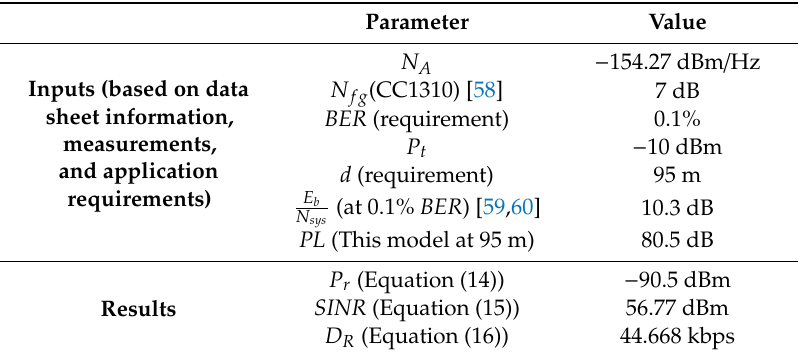
Table 3. Example explaining how to estimate the achievable data